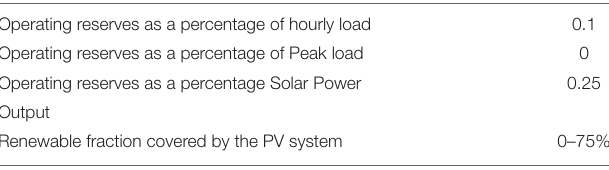
TABLE 6 | Net present costs of the system for installation of NZEB.